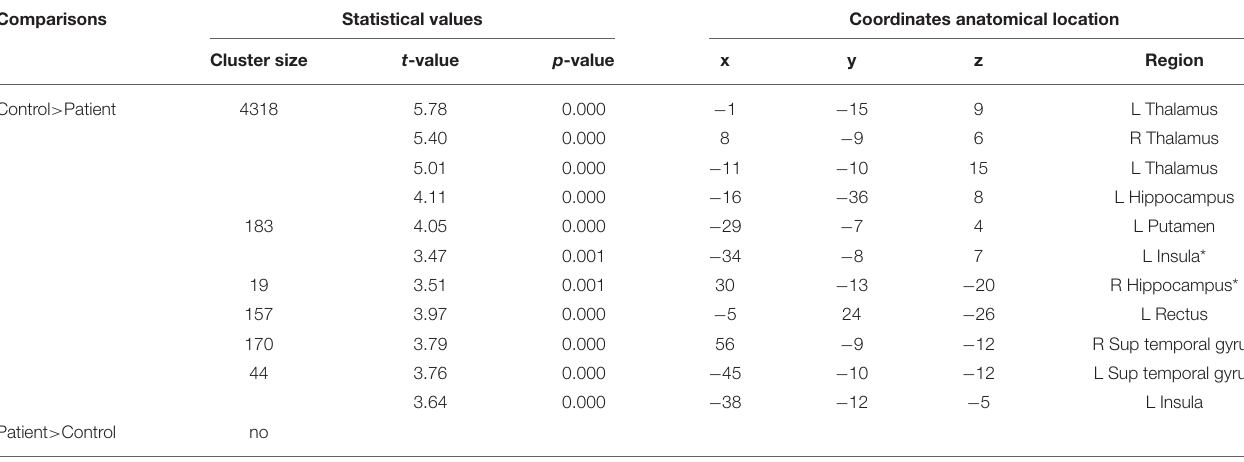
TABLE 2 | Regions of significant volume changes between patients and controls.